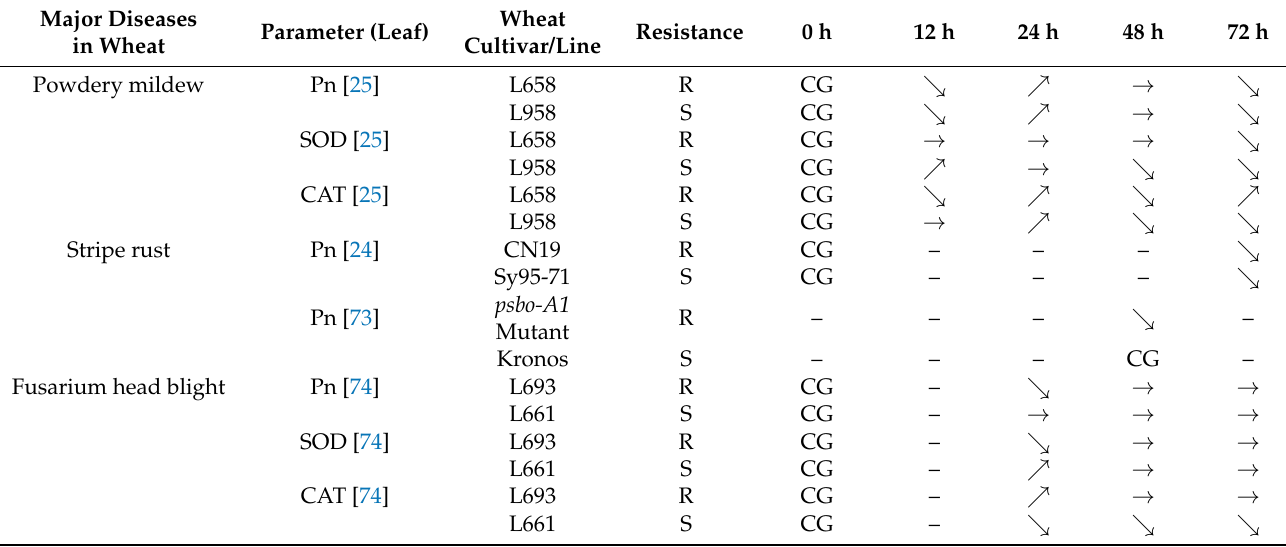
Table 2. Changes in photosynthesis and antioxidant enzyme activity in response to the three main fungal pathogens in wheat at the early stage of infection (within 72